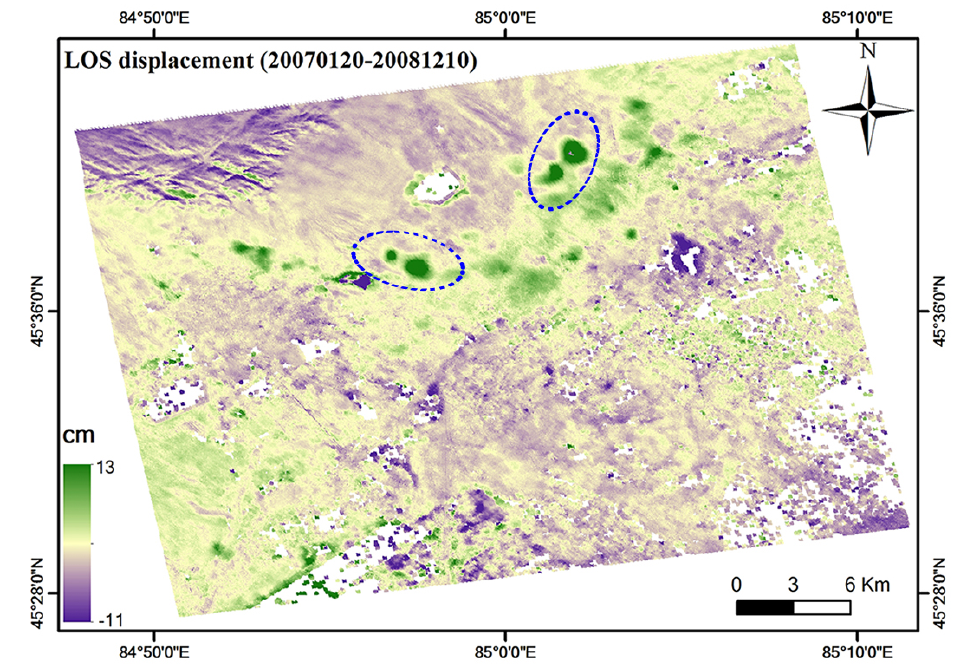
Figure 5. Geocoded displacement map in the line of sight (LOS) direction obtained by the differential SAR interferometry (D-InSAR) analysis from the ALOS-PALSAR data pair. Positive (negative) values indicates the ground close to (away from) the satellite.